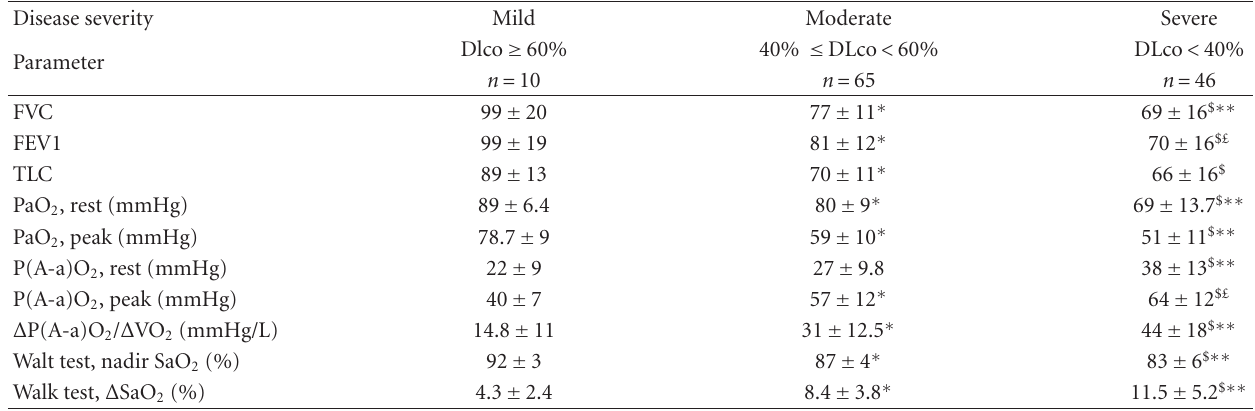
Table 4: Rest and exercise parameters as a function of disease severity defined by DLco%: mild: DLco ≥ 60%, moderate: DLco < 60% and ≥ 40% and severe (advanced disease): DLco < 40% [7].